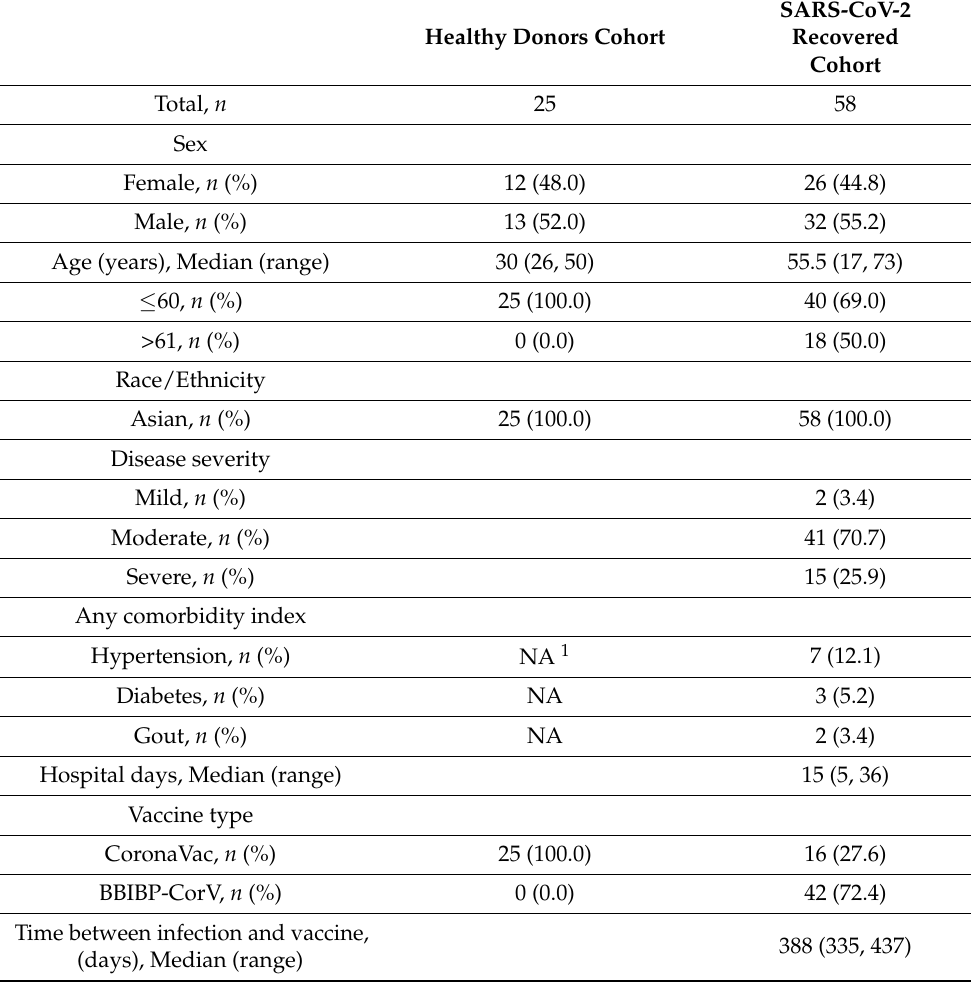
Table 1. Characteristics of SARS-CoV-2 Recovered individuals and healthy donors in the